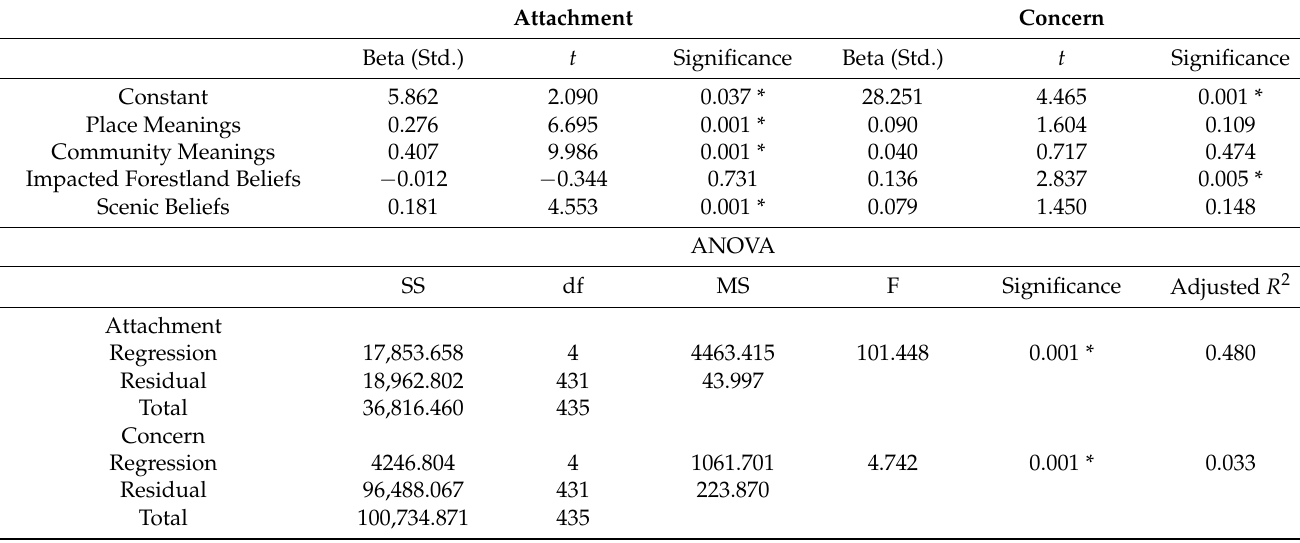
Table 3. Place meanings and evaluative beliefs effects on place attachment and landowner concern.